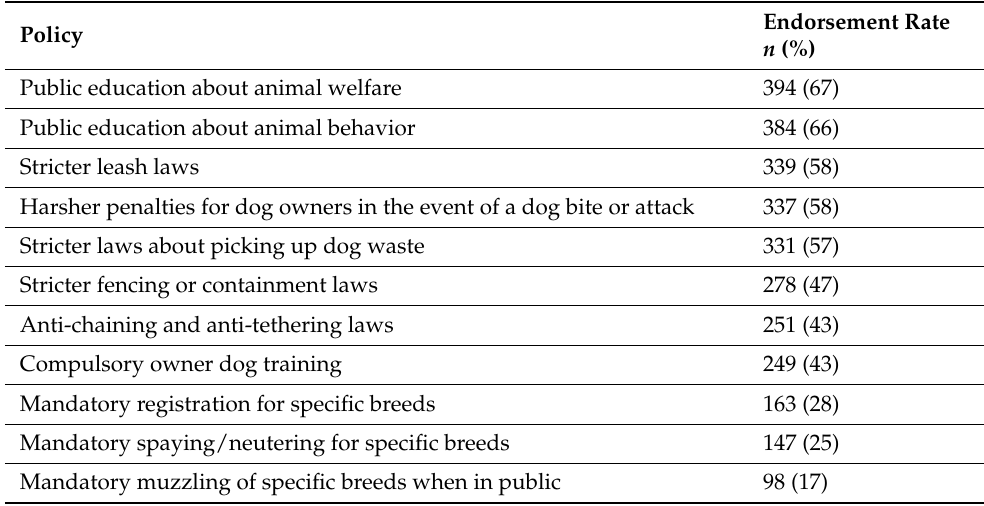
Table 4. Participants’ endorsement of community policies enacted in efforts to increase public